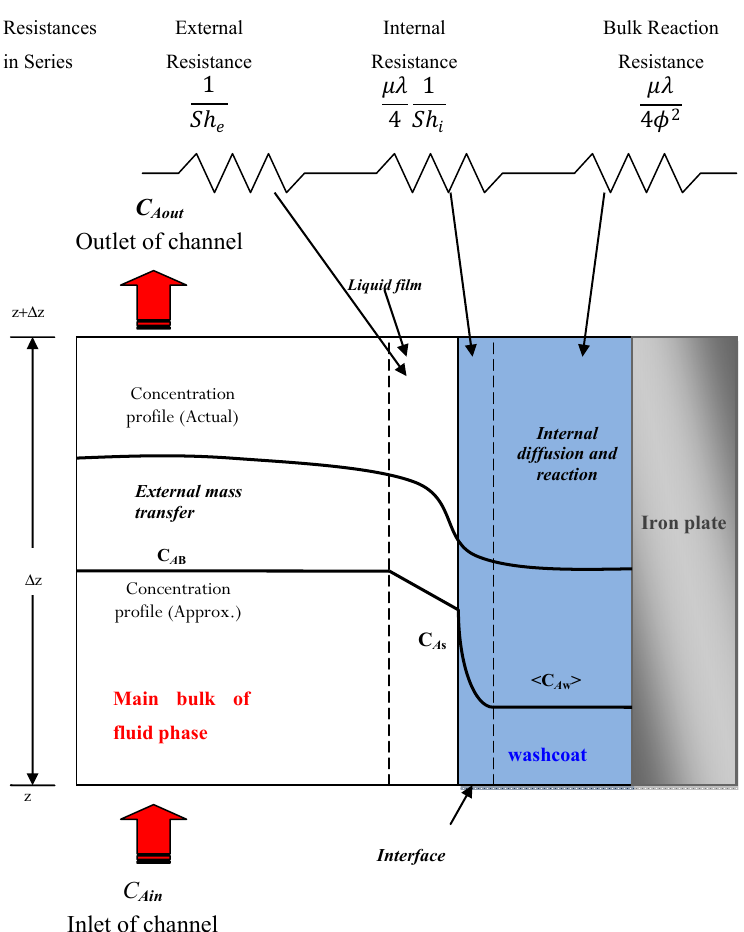
Figure 1. Schematic diagram of the control volume that illustrates the fluid-solid mass transfer during a chemical reaction in the washcoat with resistances using a series